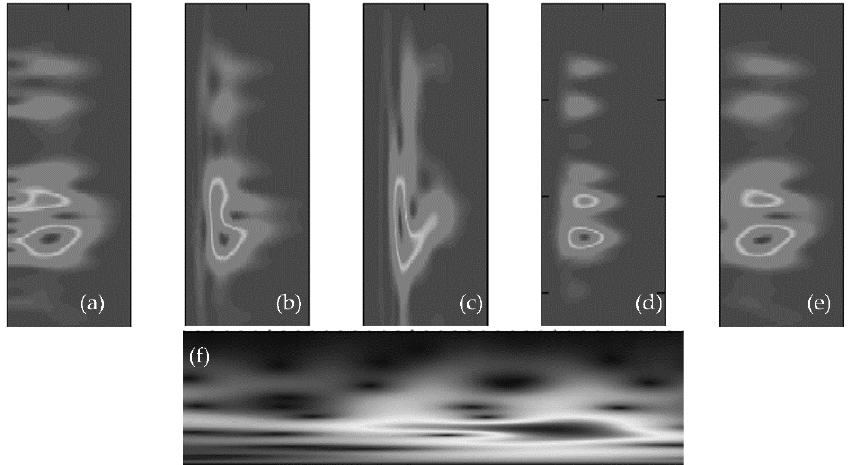
Figure 9. Time–frequency spectrum analysis of selected sample. ( a ) TF features, ( b ) STFT spectrogram and its inverse in ( c , d ), respectively, ( e ) CWT image, ( f ) Combination of CWT and STFT used in this paper.